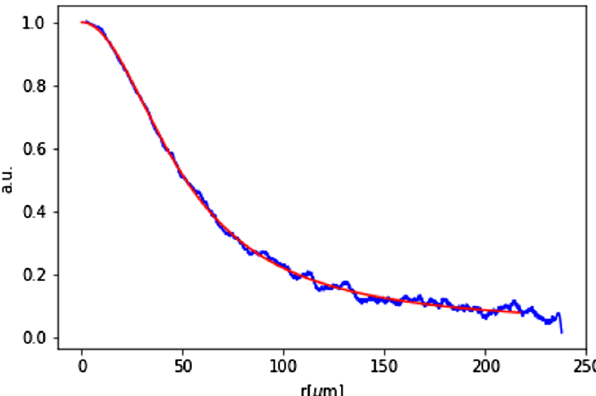
FIG. 8. Normalized radial intensity distribution obtained from 31 single-electron detection events. The data points (10974) are smoothed out using a Savitzky-Golay filter with a window size of 601 and a polynomial order of 3. The fitted Voigt profile represents a convolution of a Gaussian profile with a FWHM of 20 . 4 μ m and a Lorentzian profile with a FWHM of 95 . 2 μ